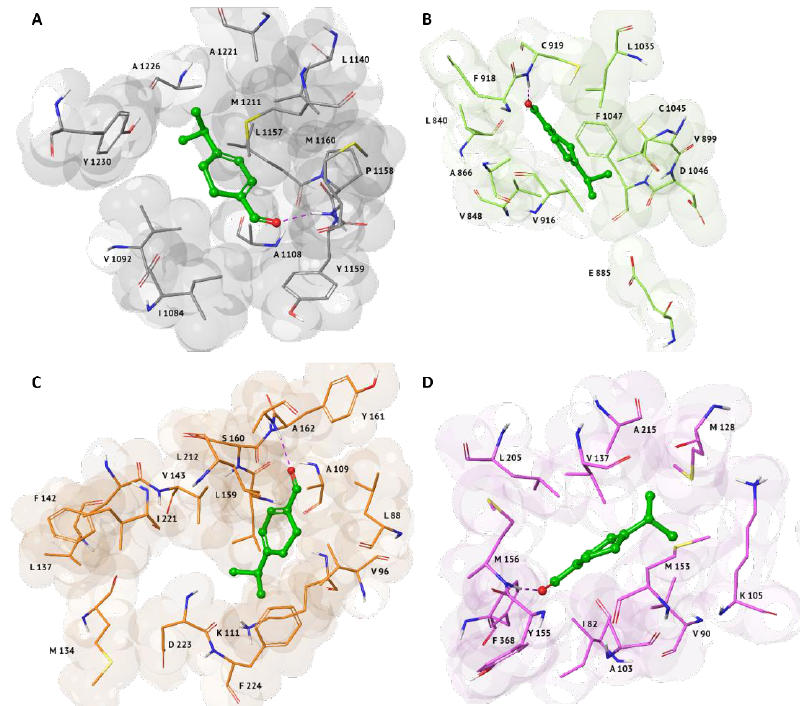
Figure 1. 3D representations of the best docking pose of α-terpinen-7-al with the following anti-cancer targets: ( A ) c-Met (PDB: 2WGJ), represented as grey surface; ( B ) VEGFR2 (PDB: 3VHE), represented as green surface; ( C ) PDK1 (PDB: 3NAX), represented as orange surface; ( D ) ROCK1 (3TWJ), represented as pink surface. Ligands are shown in green carbon ball-and-sticks, while amino-acid residues involved in the molecular interactions are shown as carbon sticks with the correspondent color of protein’s surface. H-bonds is displayed as purple dashed lines.